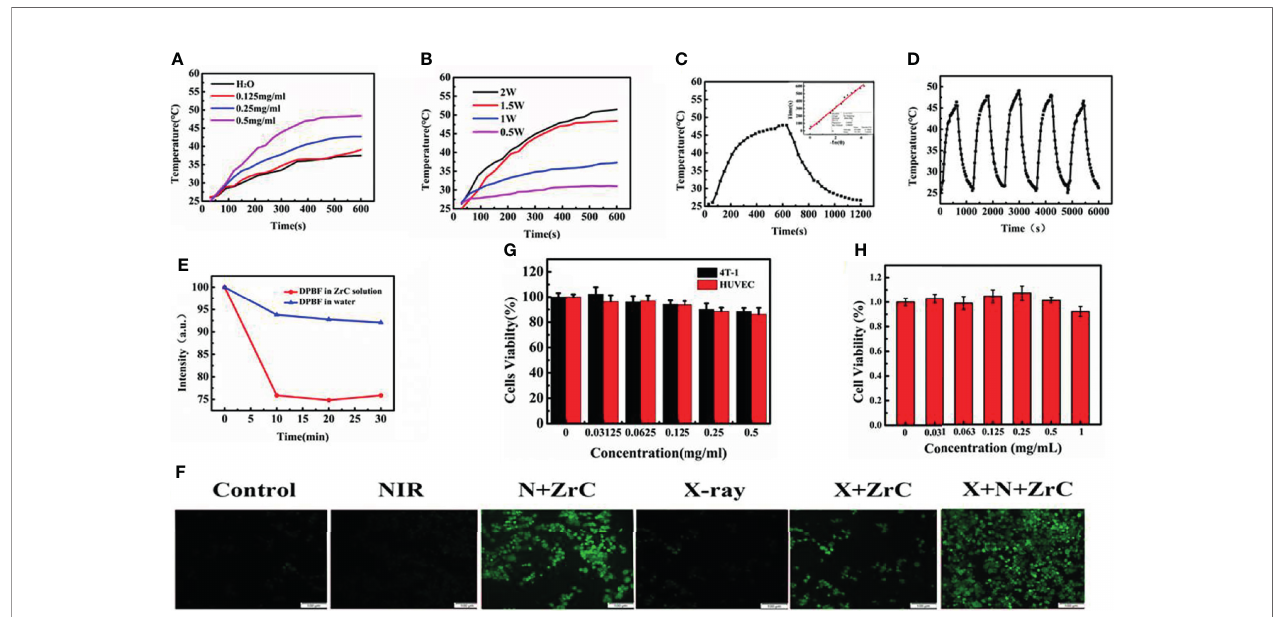
FIGURE 2 | (A) Photothermal temperature curves of ZrC NPs aqueous dispersions at different concentrations. (B) Photothermal temperature curves of ZrC NPs aqueous dispersions at different power of NIR laser. (C) Photothermal test of ZrC dispersion of 0.5 mg·mL-1. (NIR laser: 808 nm, 1.5 W·cm-2; inset shows plot of time versus – ln ( Ɵ ); The ZrC dispersion was irradiated with NIR for 10 min and left to natural cooling for another 10 min), (D) Temperature change of ZrC NPs solution at concentration of 0.5 mg·mL-1over fi ve laser on/off cycles. (808 nm laser irradiation, with a power density of 1.5 W cm-2. (E) DPBF degradation behavior for ROS detection (NIR laser: 808 nm, 1.5 W·cm-2); (F) Confocal fl uorescence images of reactive oxygen species (ROS) in 6 groups. (G) In vitro cytotoxicity of different concentrations of ZrC NPs to 4T1 cells and HUVE cells, (H) The biocompatibility of ZrC NPs on proliferation ability of 4T1 cells at different concentration (0, 0.03215, 0.0625, 0.125, 0.5 and 1 mg/ml) after incubation for 48 h. Error bars represent mean ± SD. (F) The cytotoxicity of ZrC NPs on 4T1 and HUVE cells at different concentration (0, 0.03215, 0.0625, 0.125, 0.5 and 1 mg/ml) after incubation for 24